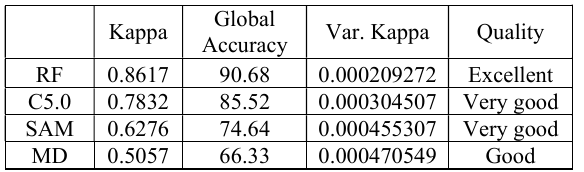
Table 2 . Performance of the algorithms of classification.